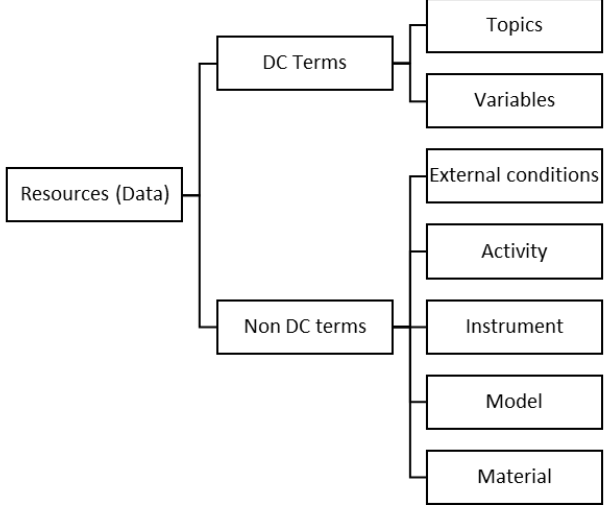
Figure 1. Classification elements as proposed in [9] for wind energy, both DC and non-DC, for the description of the single resource.